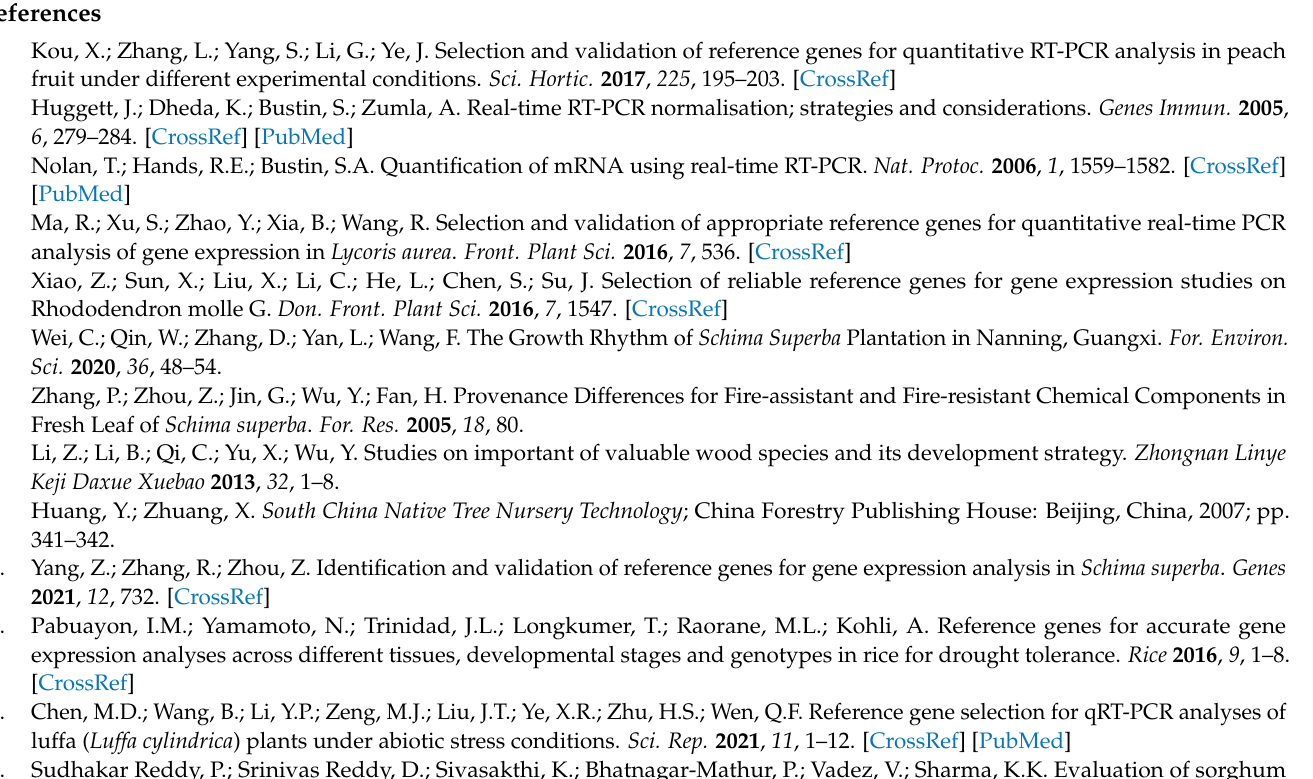
Table S1: Primer design of reference